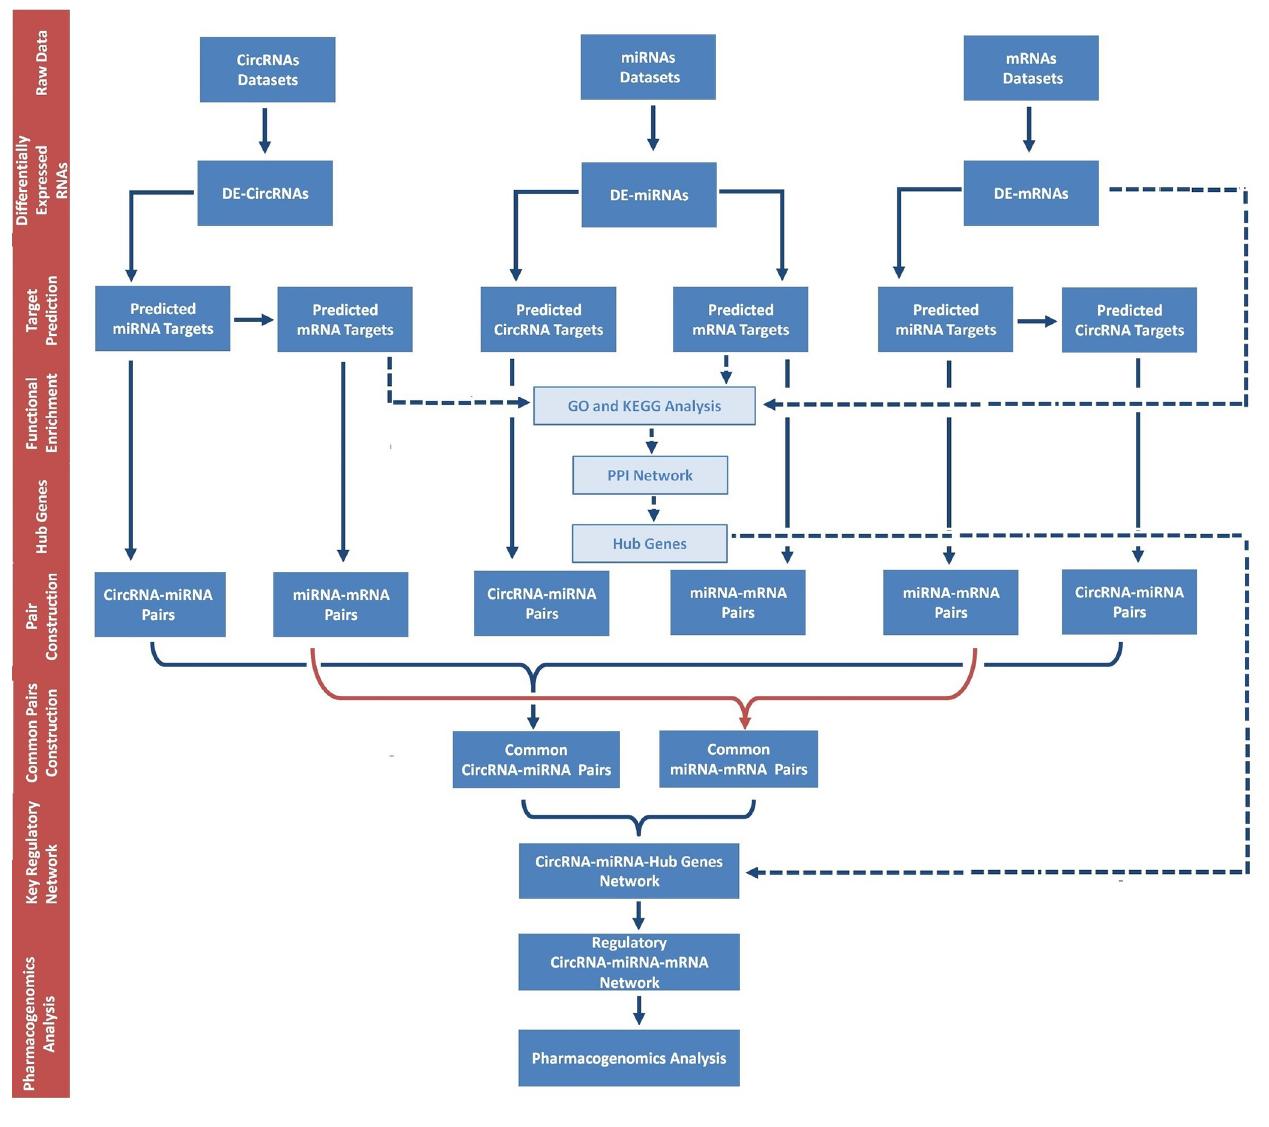
Fig 2. Flow chart of the approach utilized in the present study for the construction of SARS-CoV-2 related circRNA-miRNA-mRNA regulator